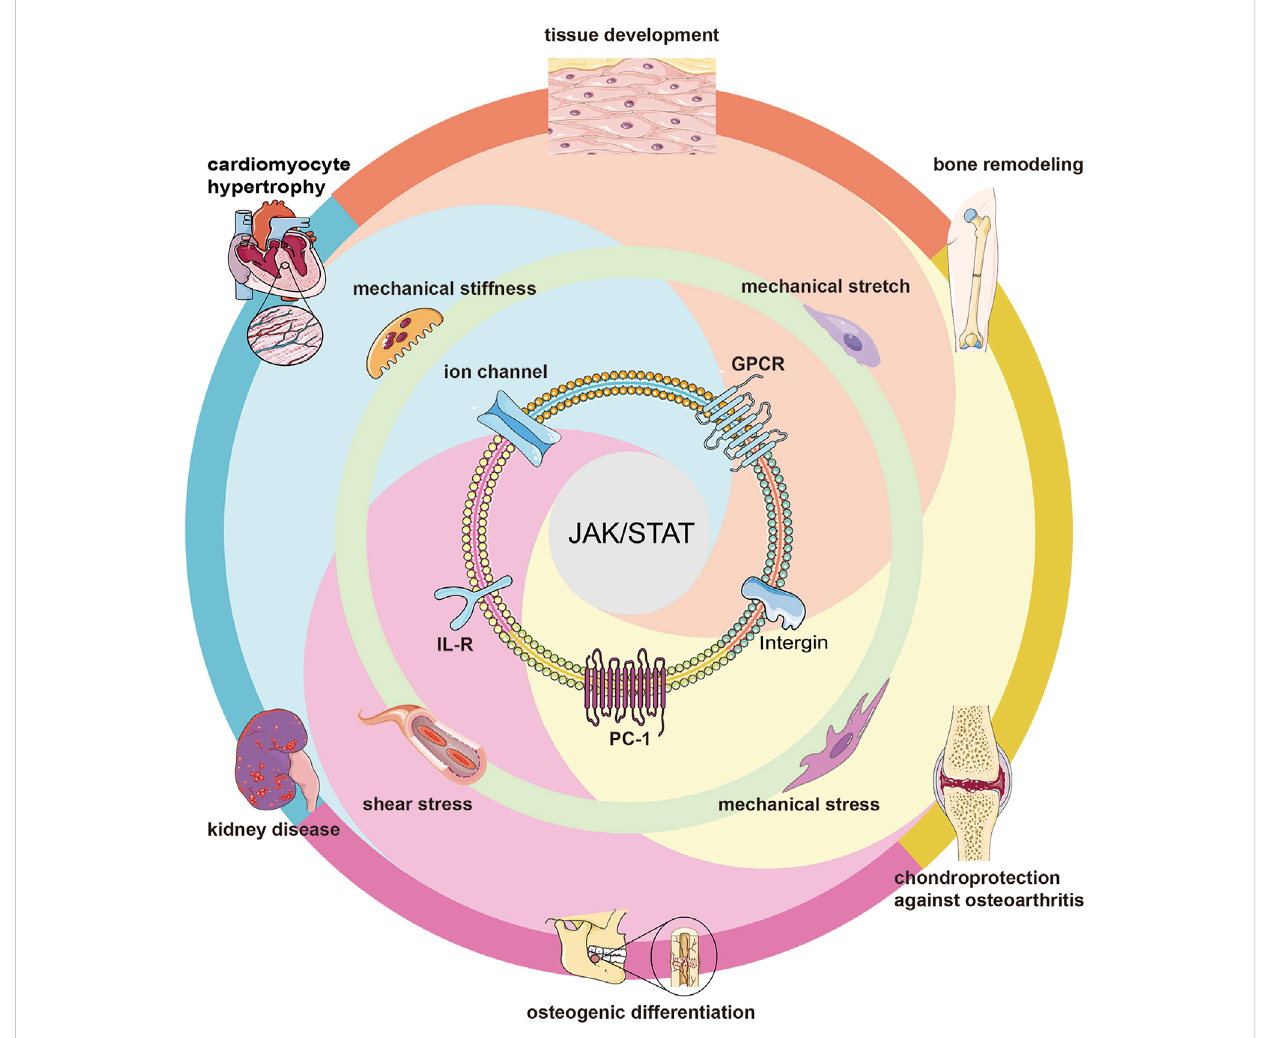
FIGURE 4 Mechanotransduction of JAK/STAT pathways. Different biophysical forces activate the JAK/STAT pathway through different membrane proteins, thus affecting many biological processes including tissue development, osteogenic differentiation, cardiomyocyte hypertrophy,